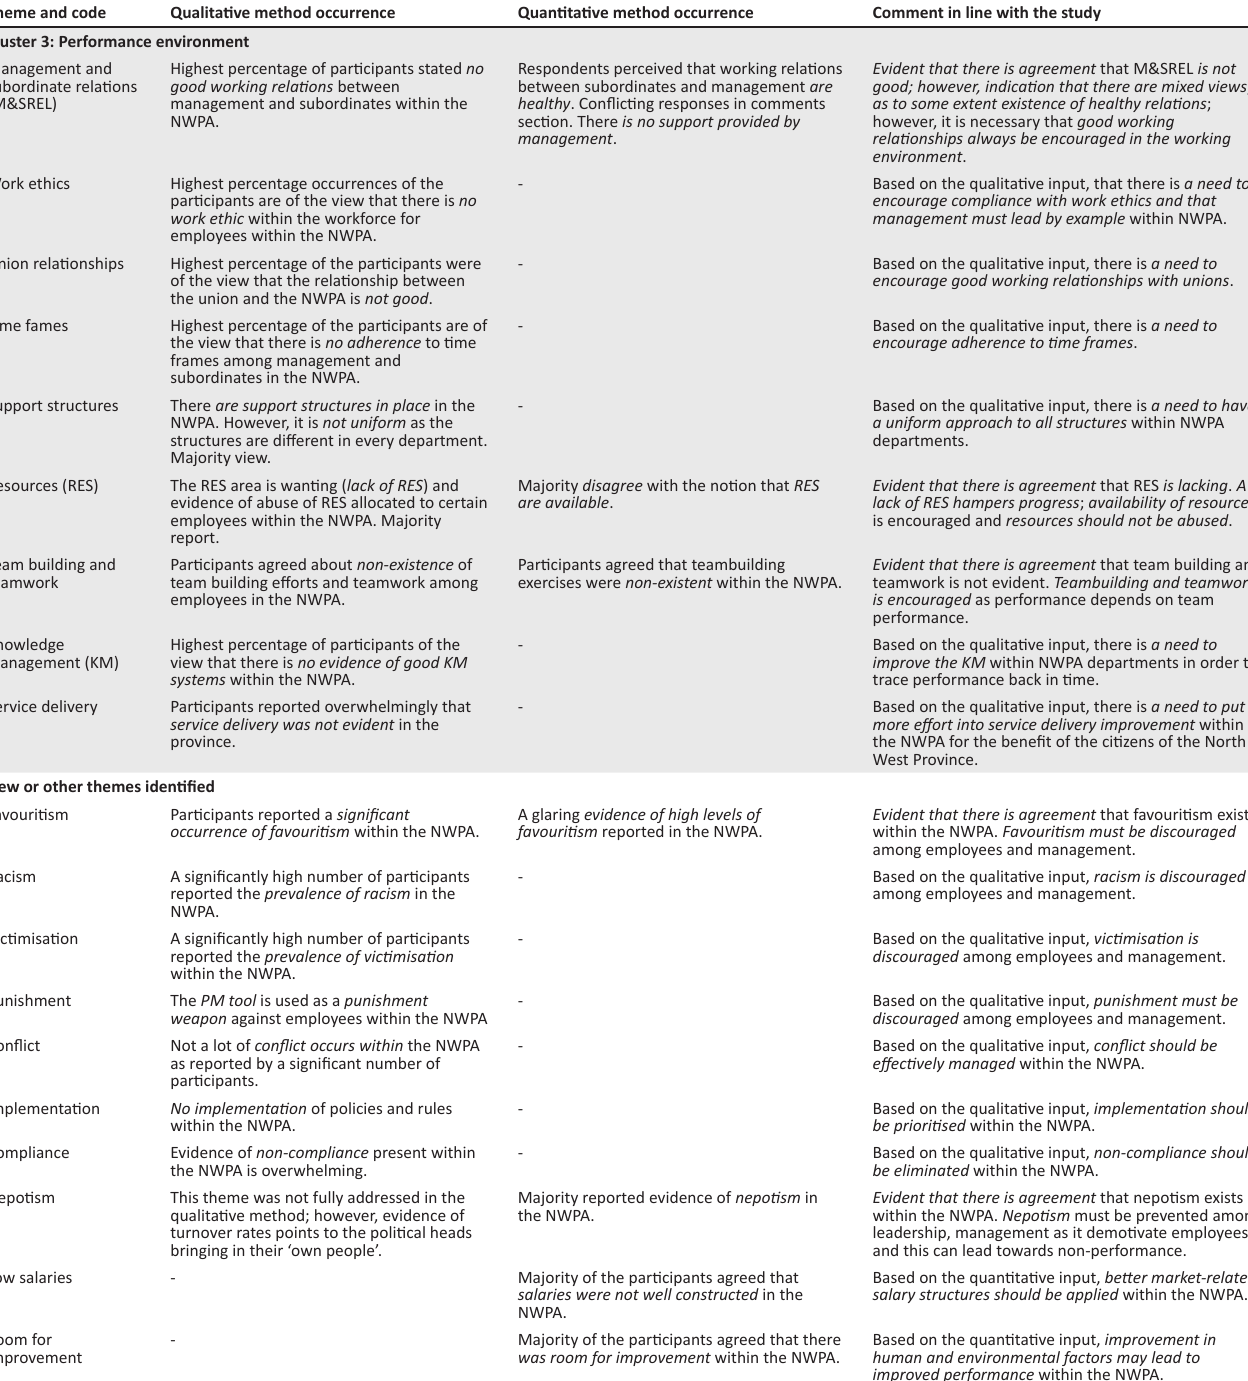
TABLE 4(Continues...): Integration and comparison of mixed-method